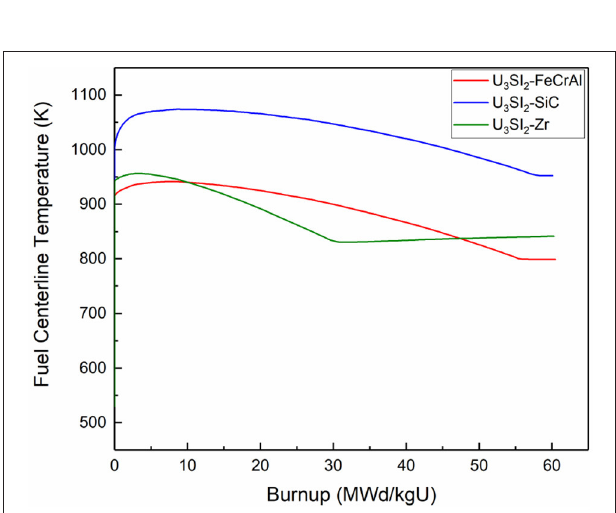
FIGURE 6 | Evolution of gap width of UO2-FeCrAl, UN-FeCrAl, and U3Si2-FeCrAl with burnups.